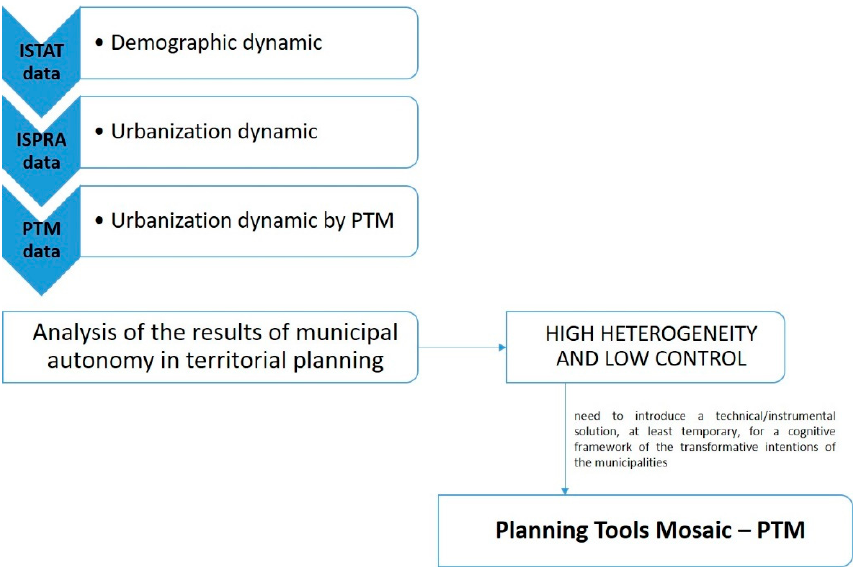
Figure 3. Flow chart of the applied methodology.